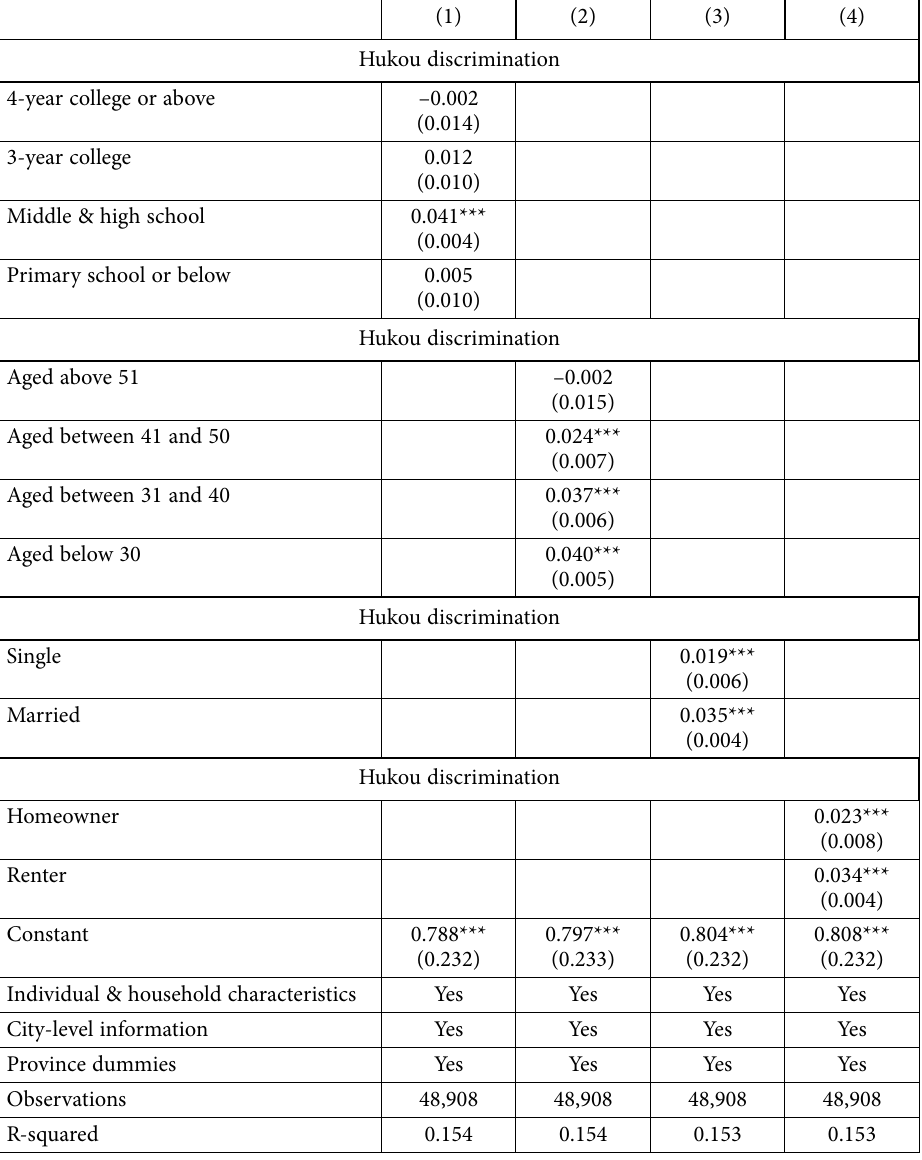
Table 8. Hukou discrimination and entrepreneurship: heterogeneity across groups (sample of rural